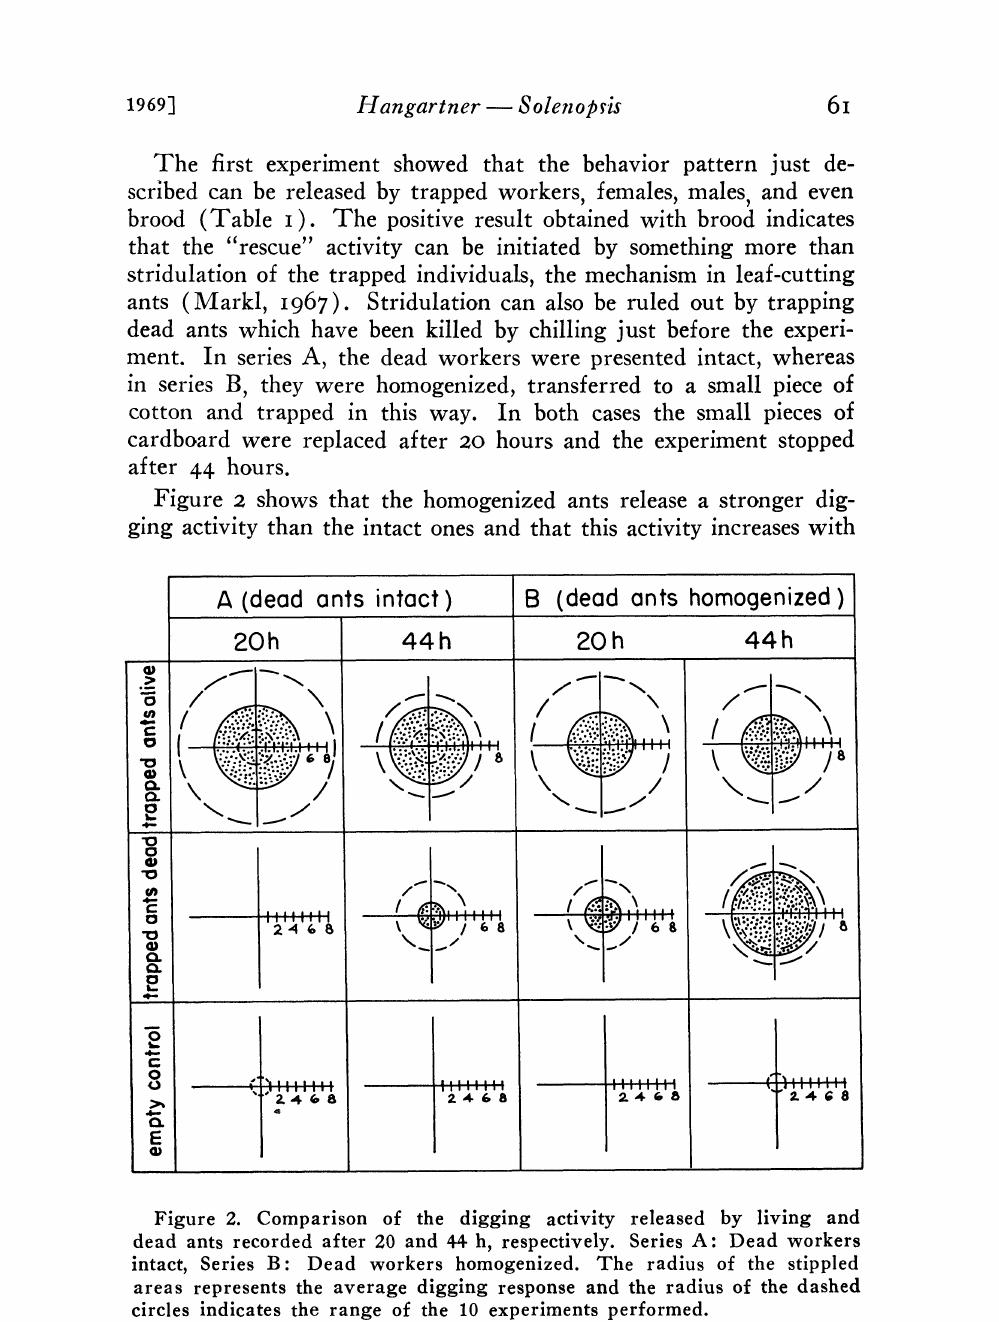
Figure 2. Comparison of the digging activity released by living and dead ants recorded after 20 and 44 h, respectively. Series A" Dead workers intact, Series B" Dead workers homogenized. The radius of the stippled areas represents the average digging response and the radius of the dashed circles indicates the range of the 10 experiments